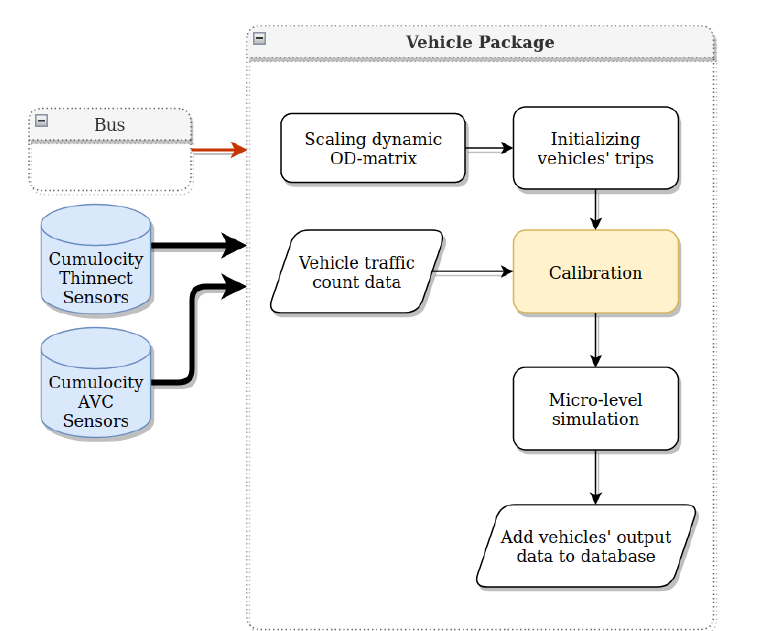
Figure 7. Vehicle package